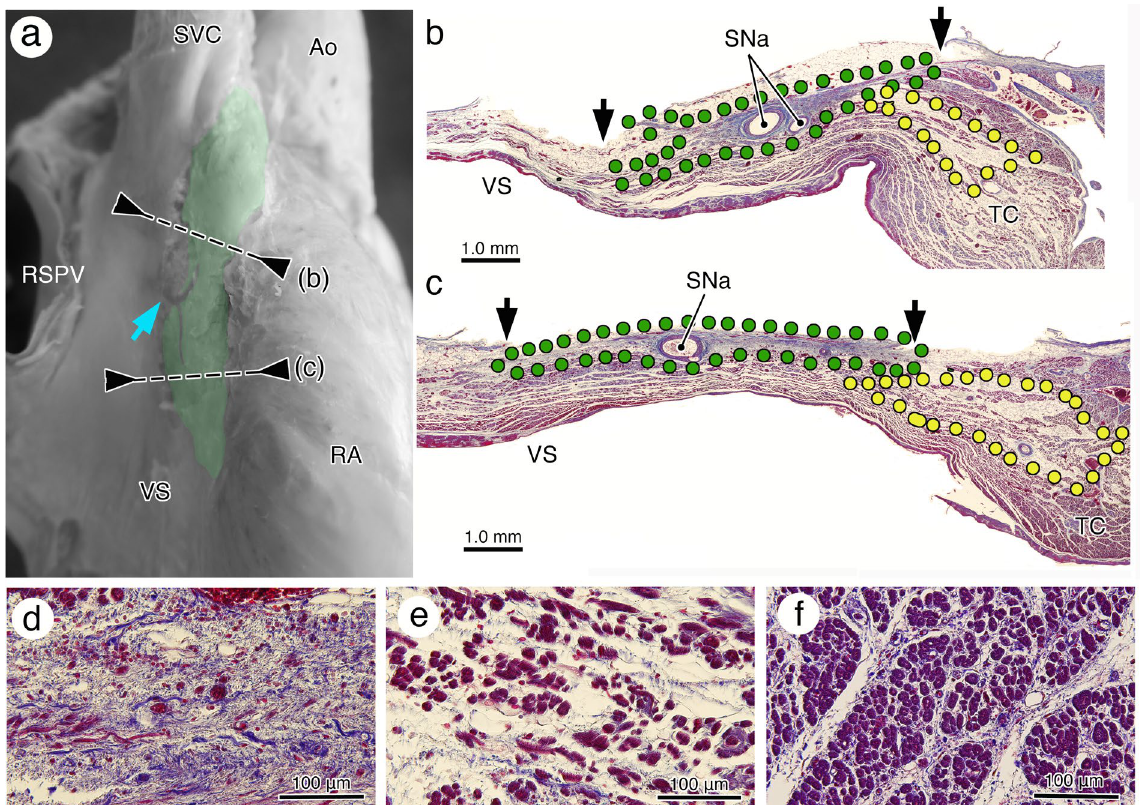
Figure 5. The anatomy and histology of the human sinus node. ( a ) The exposed sinus node, colored in green, after removal of the pericardium and adipose tissues. The sinus node is distinguishable from the surrounding cardiac structures by its location on the terminal groove, yellowish white color, and occasional appearance of the sinus node veins, indicated by blue arrows. The identified sinus node indicated section points for histologic reconfirmation. ( b, c ) The histologic reconfirmation. Sections of the proximal ( b ) and distal ( c ) parts of the exposed sinus node (green dot area and black arrows) with the paranodal area (yellow dot area). The sinus nodal cells ( d ), paranodal cells ( e ), and atrial muscular cells ( f ) are distinct from the cells themselves, extracellular matrix, and their population and size. Ao aorta, RA right atrium, RSPV right superior pulmonary vein, SNa sinus node artery, SVC superior vena cava, TC terminal crest, VS venous